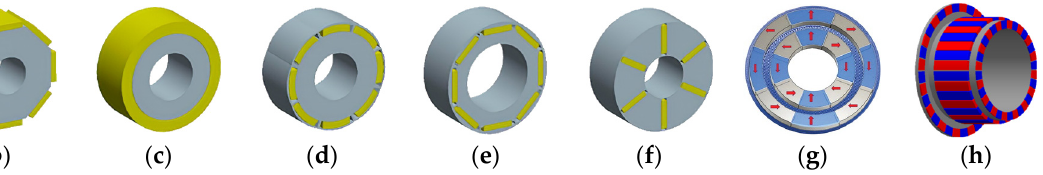
Figure 5. Rotor topologies: ( a ) Arc surface-mounted; ( b ) Rectangular surface-mounted; ( c ) Ring-type; ( d ) Buried arc type; ( e ) Buried type; ( f ) Inset type; ( g ) Halbach arrays; ( h ) Enhanced hybrid.